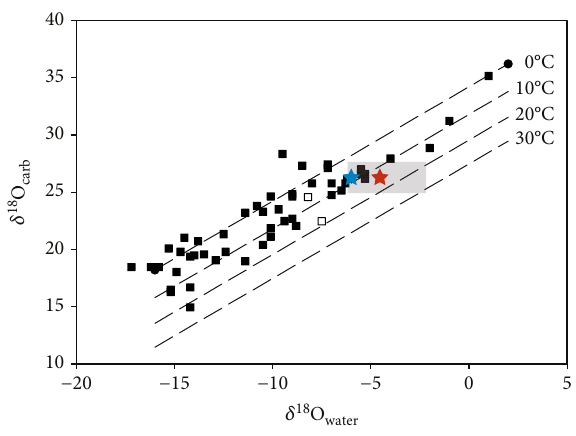
Figure 8: Plot of δ 18 O versus δ 18 O of meteoric water for each carb soil shown in Figure 5. Isotherms have been calculated using Kim and O ’ Neil [49]. Black squares are the data from Cerling and Quade [25], and white squares are the multisoil pit means for Arizona (this study). The red star represents the mean measured δ 18 O value for pedogenic carbonates from Gutierrez and carb Sheldon [27]; δ 18 O was based upon an independently water reconstructed MAT of 13 ° C for the paleosols and a fractionation factor from Kim and O ’ Neil [49]. The blue star is the interpolated mean annual δ 18 O value from the OIPC [24]. The grey box water shows the seasonally adjusted (March – September) modern range of δ 18 O values for the present day latitude and longitude. For water modern soil sites without direct measurements of the δ 18 O of meteoric water (white squares), the OIPC was used to calculate the